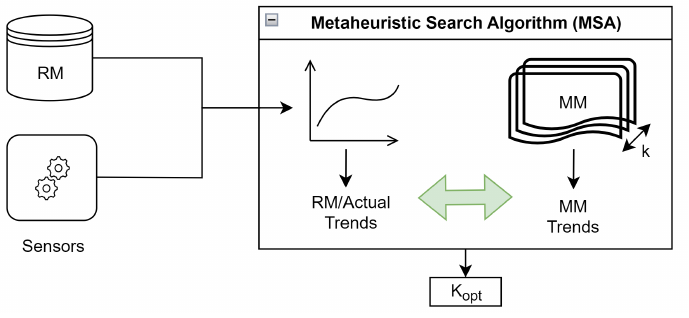
Figure 1. FDI methodology overview